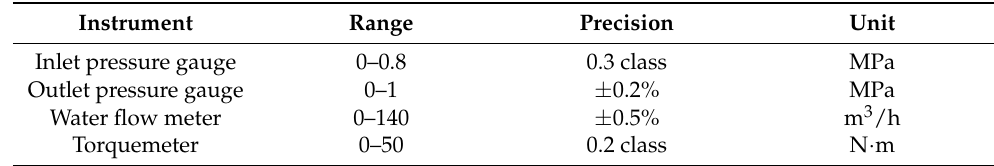
Figure 5. Partial system configuration. ( a ) torque meter ( b ) experimental data acquisition system. Table 3. The precision of main equipment.